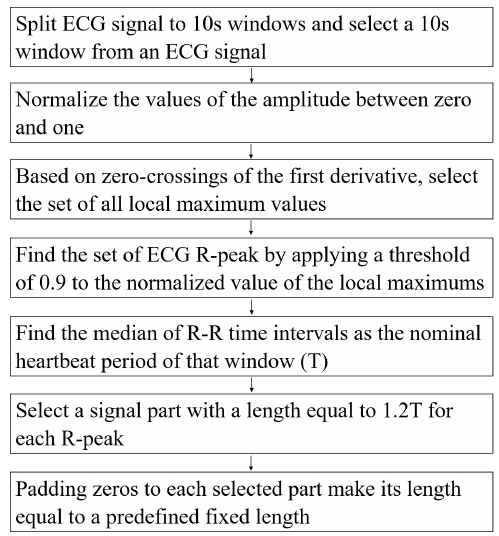
Figure 2. The pre-processing steps.